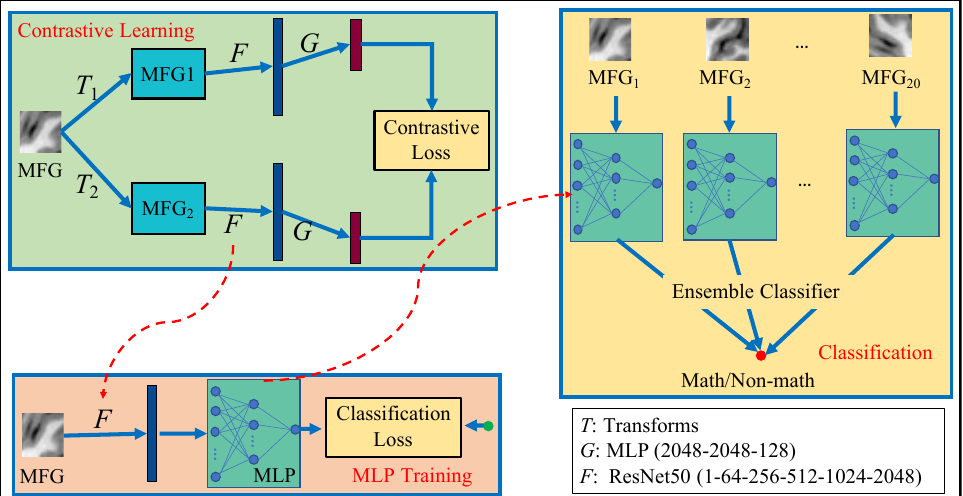
Figure 2. Our workflow. There are three steps, i.e., contrastive learning for deep features, MLP training for base classifiers, and Classification for combining multi-instance